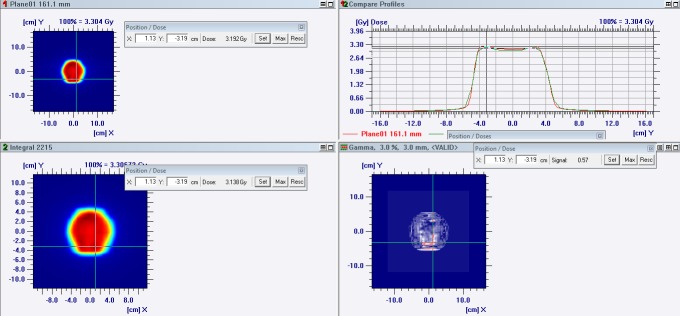
2D GI analysis in the OmniPro system.Comparison of profiles on the X- and Y-axis in patients with prostate cancer.